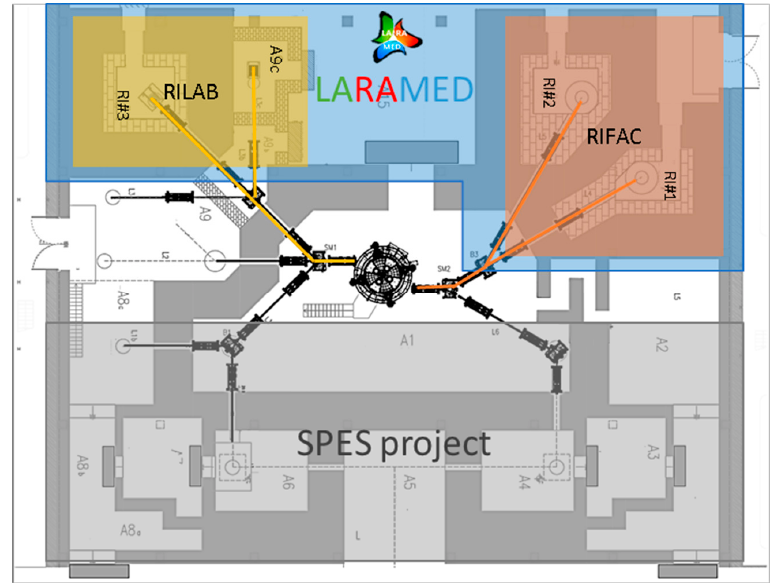
Figure 3. The layout of the SPES building (underground level) showing the cyclotron with outward beam-lines. In evidence, the LARAMED section (colored in blue) comprising four bunkers (RI#1, RI#2,